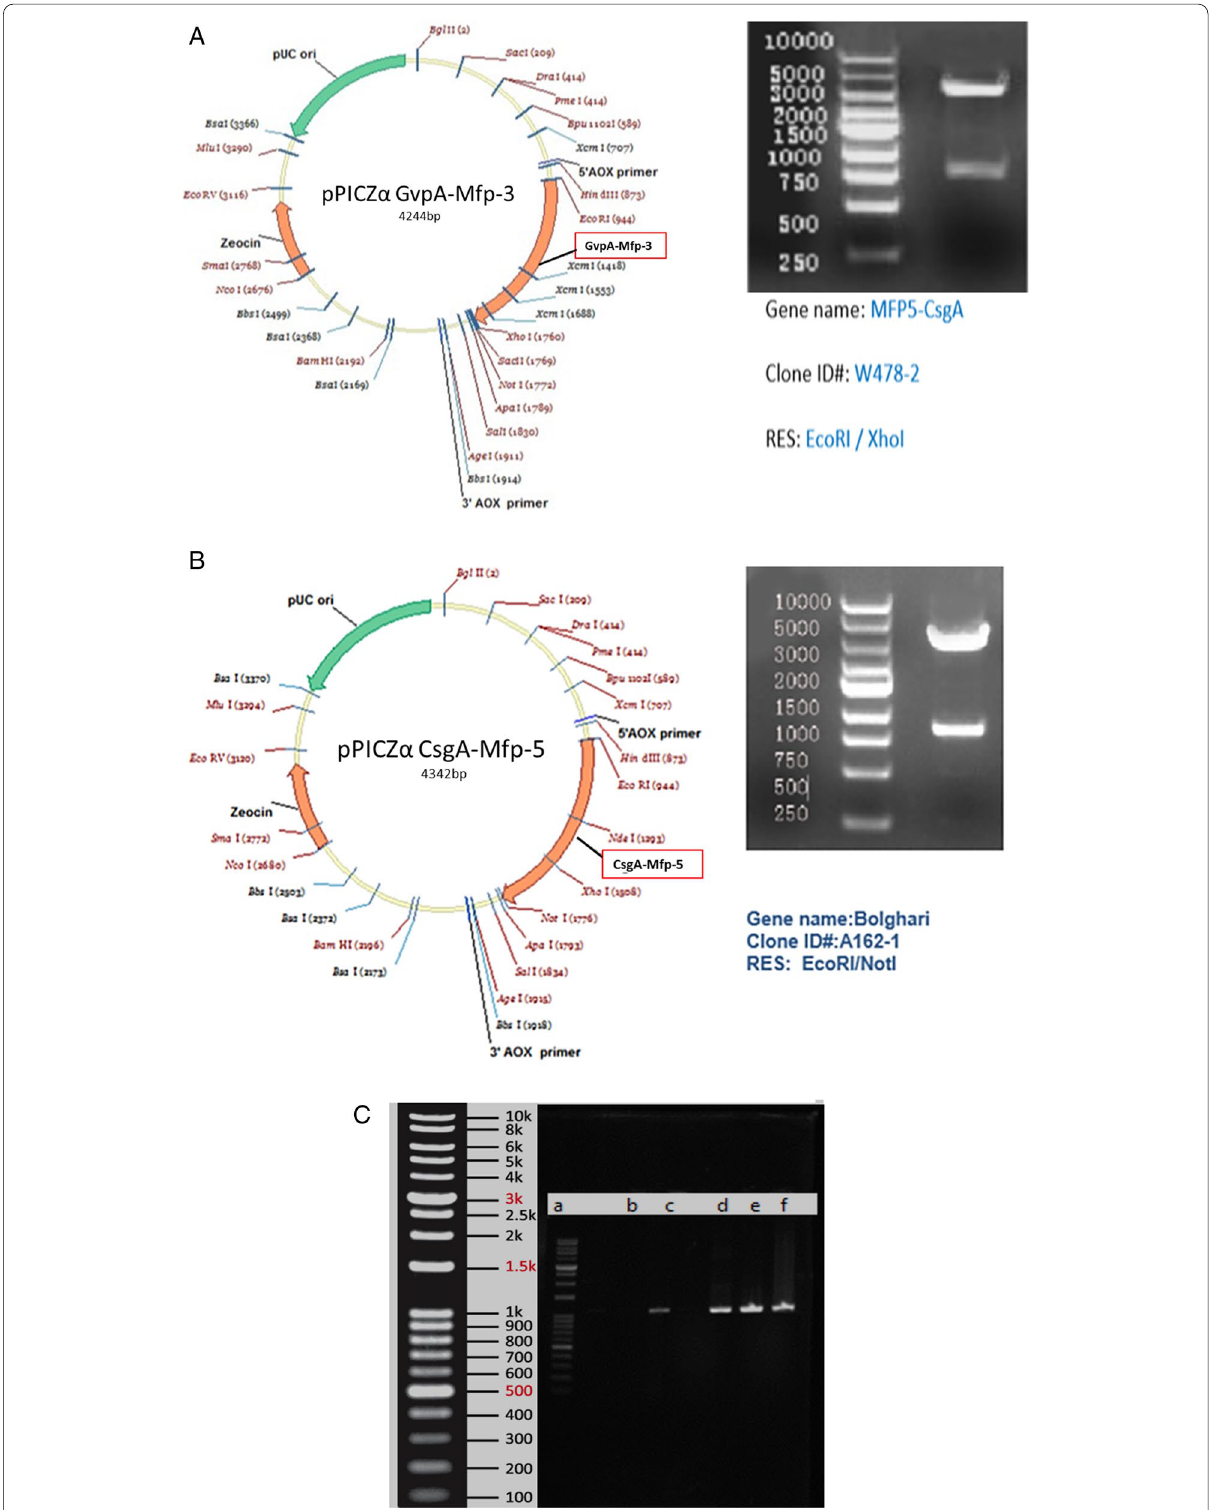
Fig. 1 Map of the pPICZα A-GvpA-Mfp3 ( A ) and pPICZα A-CsgA-Mfp5 plasmid construction ( B ). Gene sequences were inserted between Eco RI and Xho I, Eco RI and Not I restriction sites, respectively. Proof of the successful transfection and presence of the desired chimeric gene in yeast by PCR amplification ( C ): Mfp5- CsgA (Lane c), GvpA-Mfp3 (Lanes d, e, f), and DNA marker (Lane